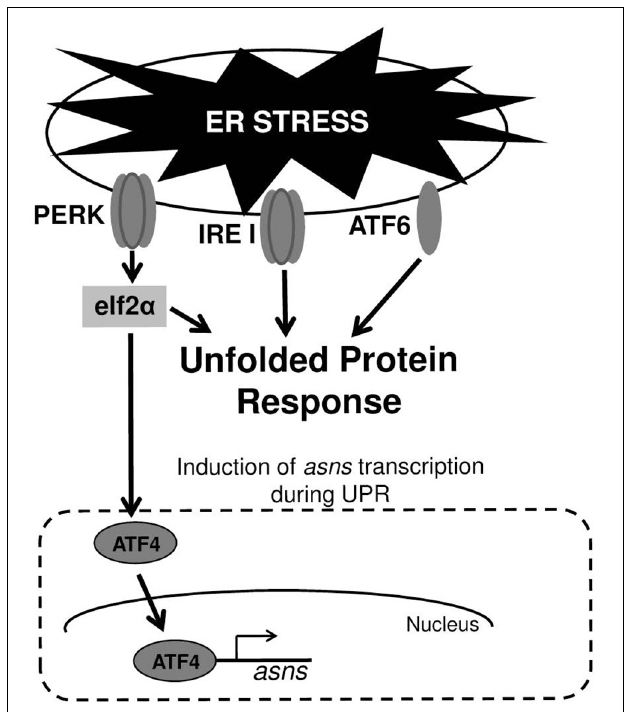
FIGURE 1 | ER stress and UPR. Upper panel —the three transmembrane receptorproteinsthatareresponsiblefortriggeringUPRincellsexperiencing ER stress. Lower panel —induction of asns transcription through the PERK/eIF2/ATF4 pathway. During UPR, PERK phosphorylates elf2 α , which in turn elevates the translation of the transcription factor ATF4. ATF4 upregulates the transcription of several genes including that of asns